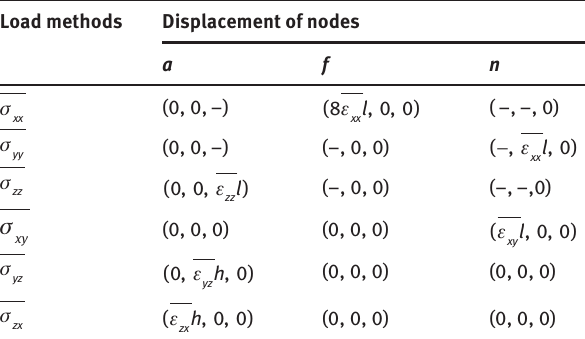
Table 3: Load methods and corresponding master node displacement. Load methods